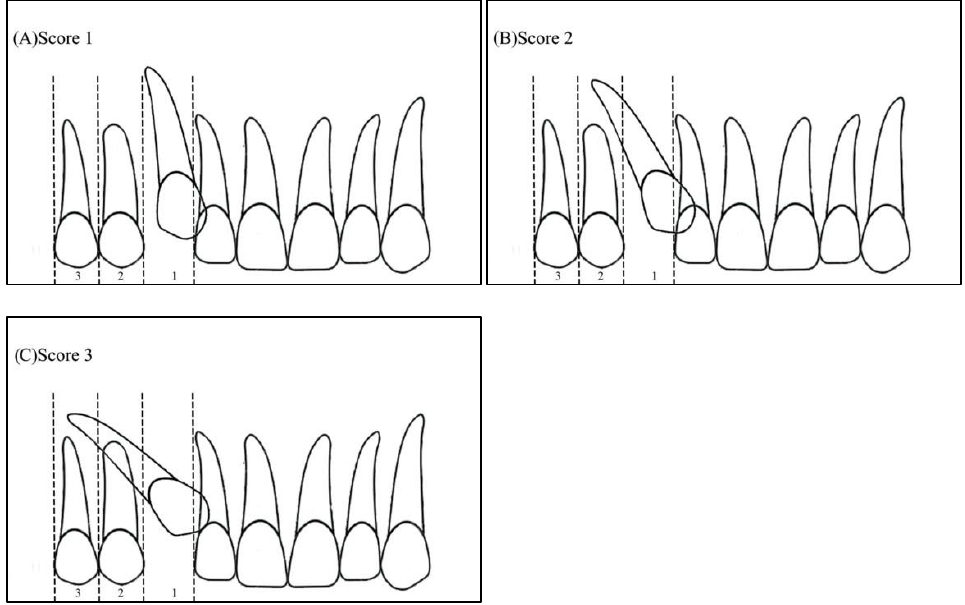
Figure 3. Apex position: ( A ) score 1 — in the area of canine apex, ( B ) score 2 — in the area of the first premolar apex, ( C ) score 3 — in the area of the second premolar apex.